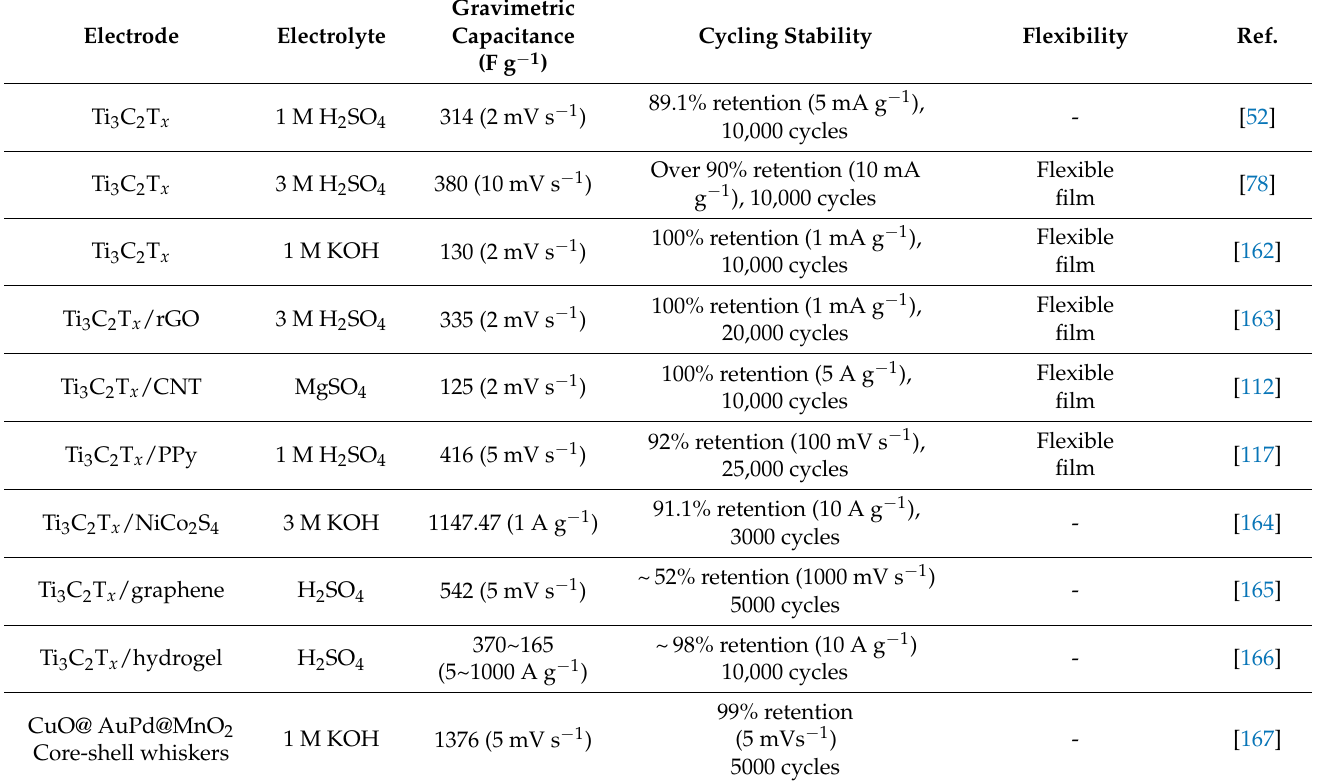
Table 3. Comparison study of pure MXene SCs, MXene composite SCs, and other